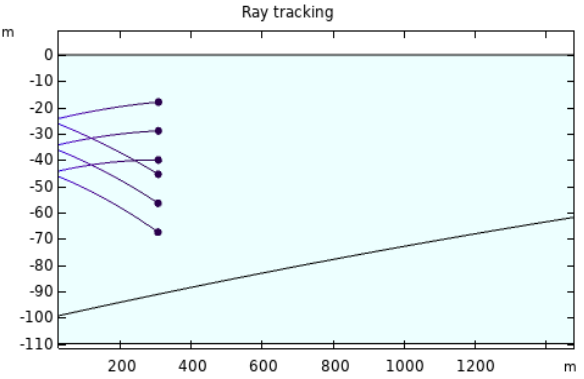
Figure 4. Ray trajectories at t = 0.2 s.